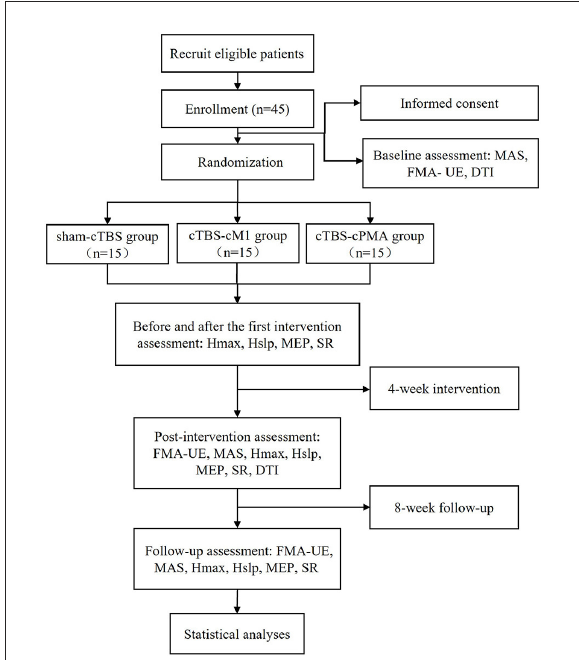
FIGURE1 The flow diagram for this study. MEP, motor evoked potential; MAS, modified Ashworth scale; FMA-UE, Fugl-Meyer Assessment of Upper Extremity Scale; SR, startle reflex; DTI, diffusion tensor imaging; Hslp/Mslp, the ratio of the slope of H and M-waves; Hmax/Mmax, the ratio of the maximum of H and